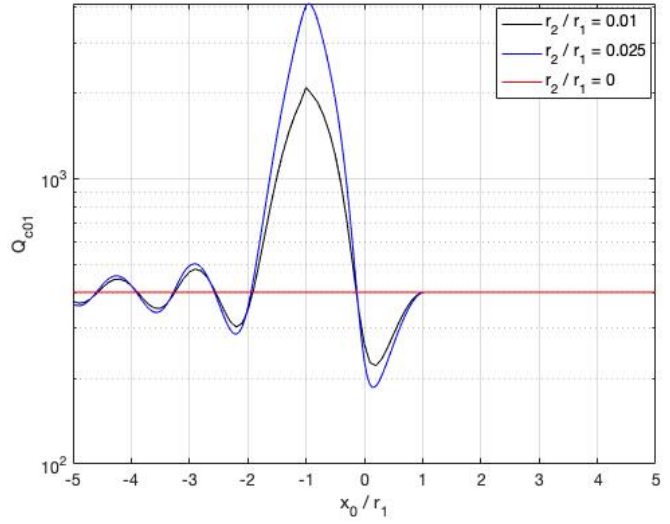
Figure 3. 𝑄 factor ( 𝑄 (cid:3030)(cid:2868)(cid:2869) ) versus relative distance 𝑥 (cid:2868) 𝑟 (cid:2869)